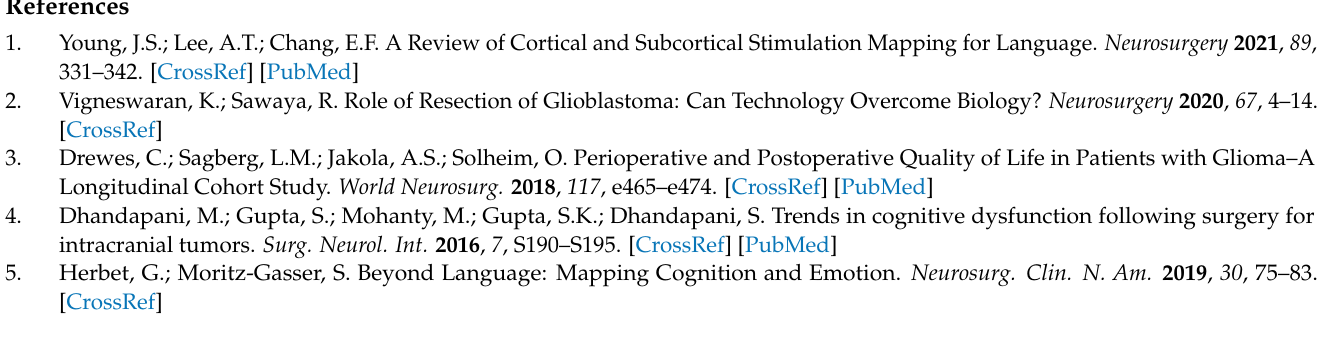
of diagnoses in all included studies according to network affiliation. Figure S3: Breakdown of Included